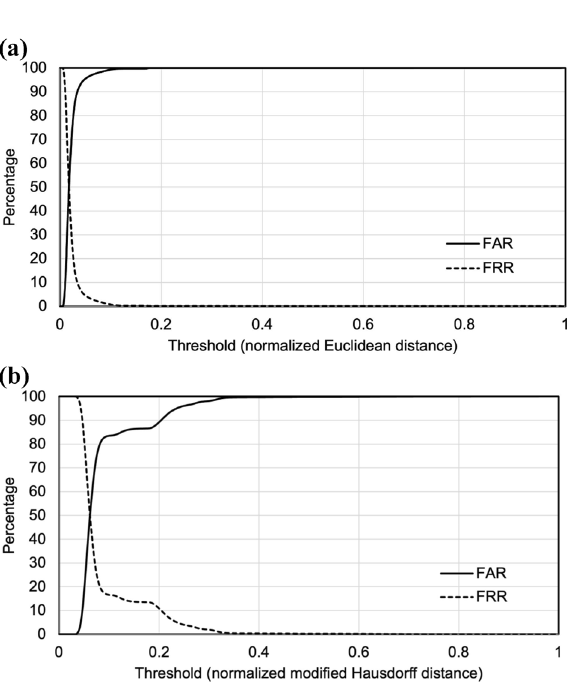
Figure 1. ( a ) Average Euclidean distance for each of rank of Euclidean distance. ( b ) Average modified Hausdorff distance for each of rank of modified Hausdorff distance.